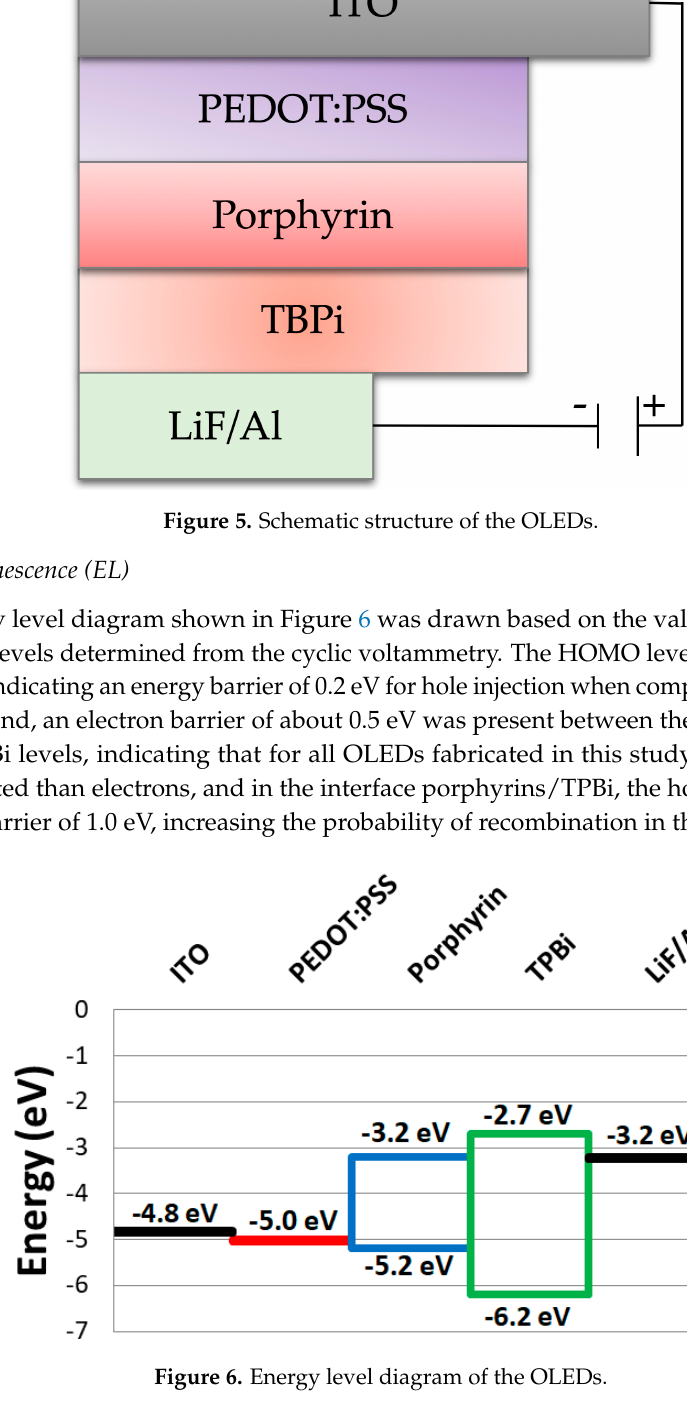
Figure 6. Energy level diagram of the OLEDs.